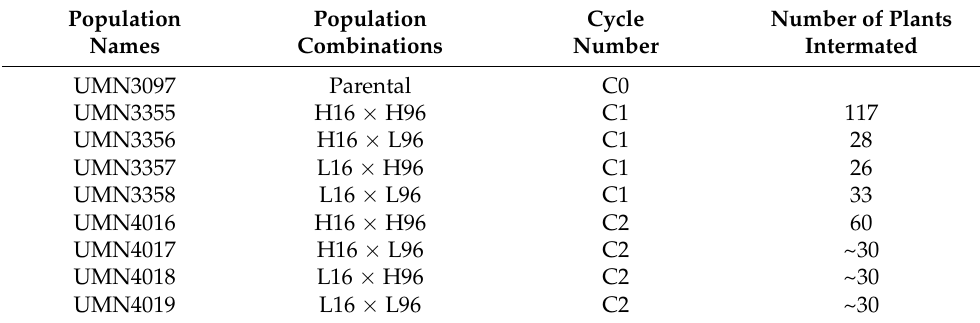
Table 1. Summary of populations used in the study. H16, high 16 h IVNDFD; H96, high 96 h IVNDFD; L16, low 16 h IVNDFD; L96, low 96 h IVNDFD. C0, unselected population; C1, cycle 1